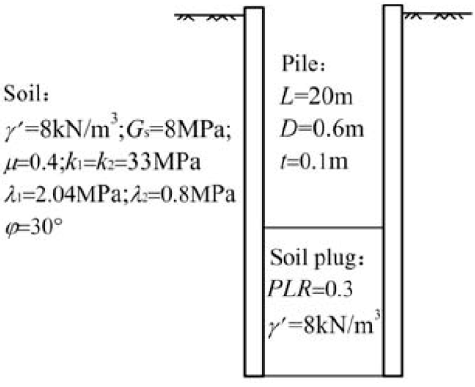
Figure 8. Sketch map of computing case.